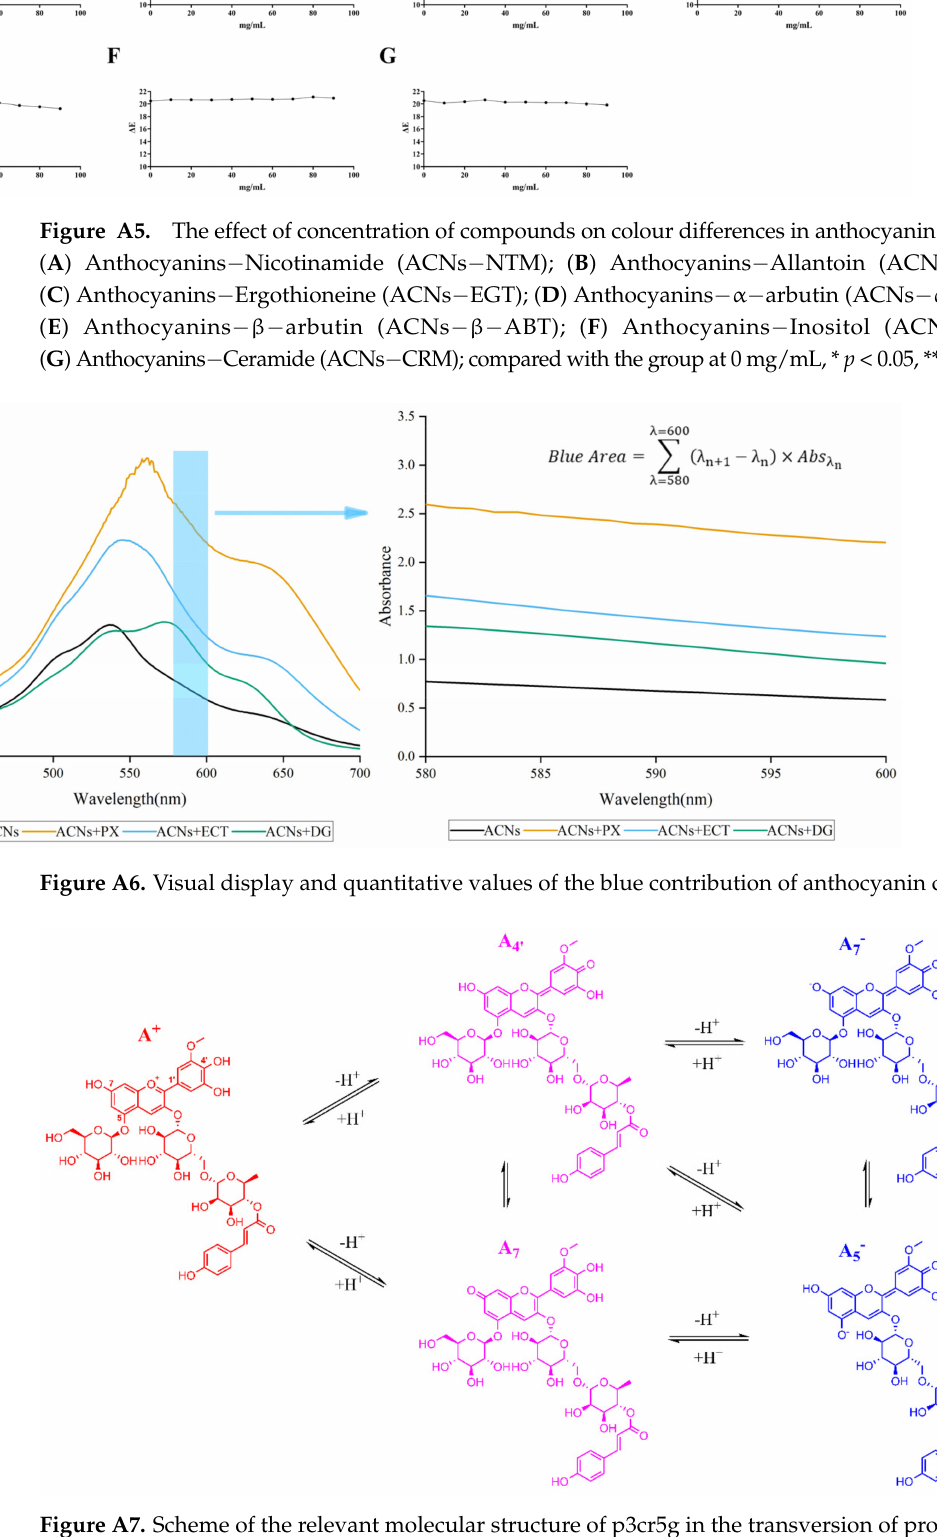
Figure A7. Scheme of the relevant molecular structure of p3cr5g in the transversion of protonation and